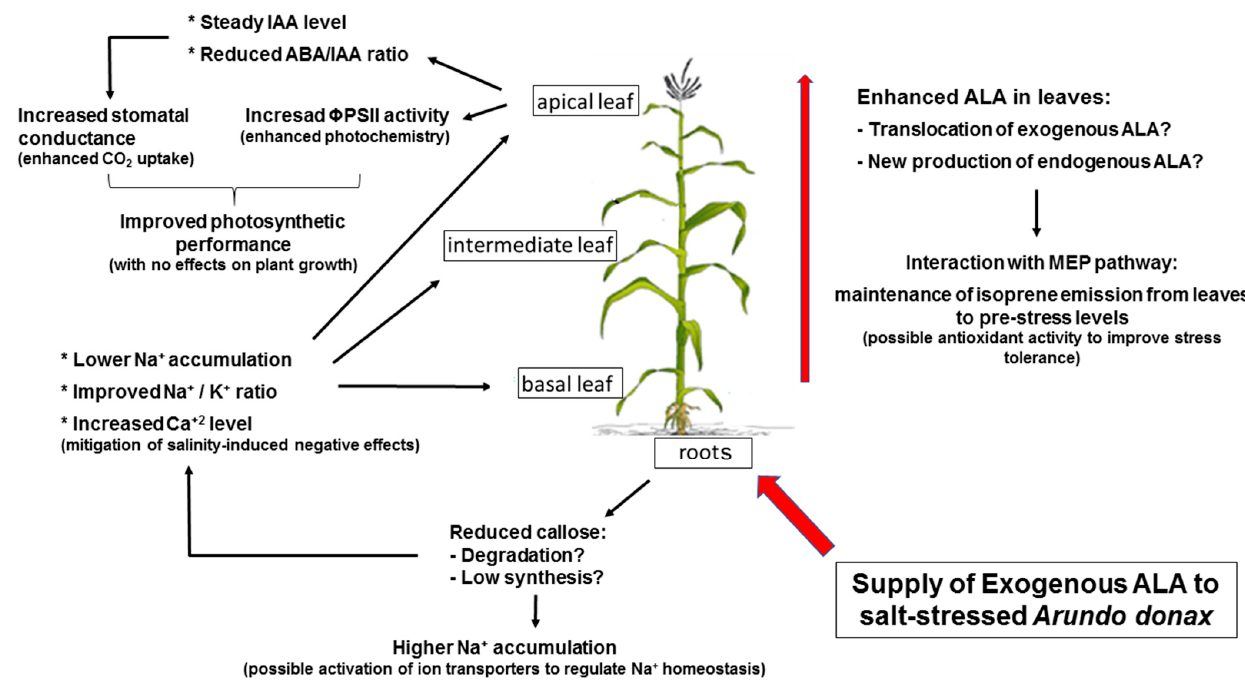
Figure 4. Synthetic overflow of the model functioning of exogenous ALA in salt-stressed Arundo donax plants.